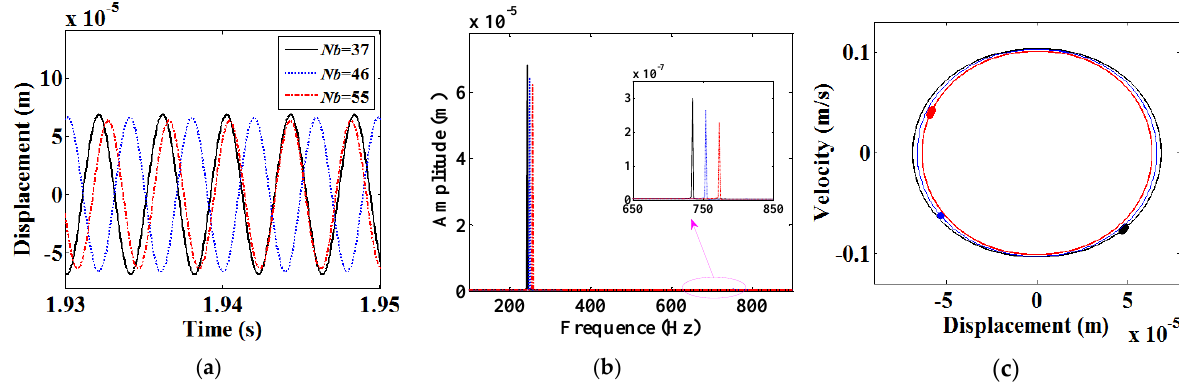
Figure 19. Vibration responses in the resonance region: ( a ) Time history; ( b ) Spectrum; ( c ) Phase diagram and Poincaré section.